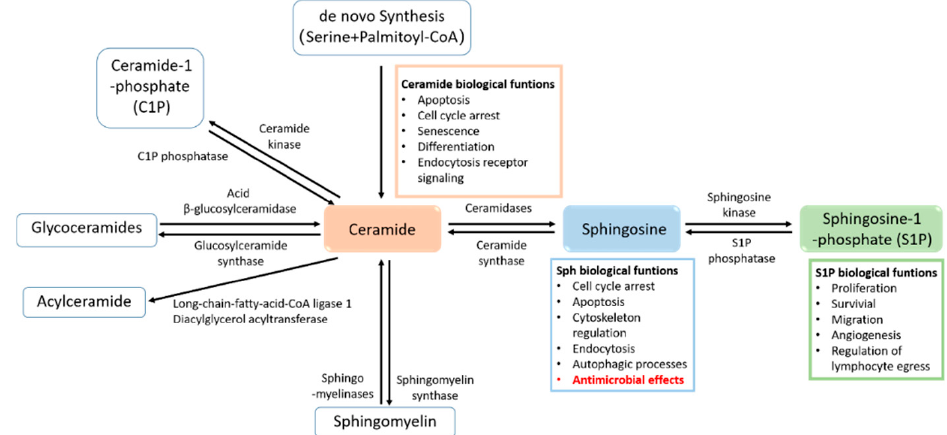
Figure 1. Sphingolipid metabolism and their biological functions. There are several pathways to synthesize ceramide. The de novo pathway generates ceramide after initiation with serine and palmitoyl CoA. Ceramides are then converted into other complex sphingolipids, including sphingomyelin, glycoceramides, and ceramide-1-phosphate. Ceramides can be acylated to acylceramide or deacylated by ceramidase to sphingosine. Sphingosine kinases phosphorylate sphingosine to sphingosine-1-phosphate. In turn, sphingolipid catabolic pathways result in ceramide from sphingomyelin, ceramide-1-phosphate, glycosphingolipids, and sphingosine. Ceramide, sphingosine, and sphingosine-1-phosphate are biologically active sphingolipids that are involved in several cellular processes.